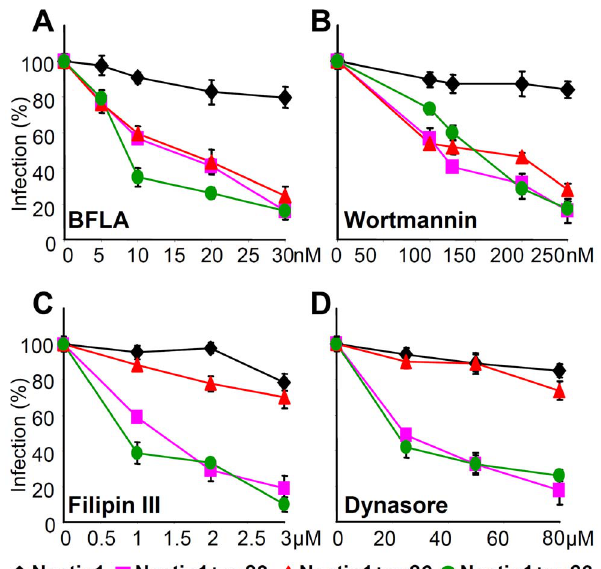
Figure 9. Effect of expression of a v b 6- or a v b 8-integrin on the pathway of HSV entry, defined through sensitivity to specific inhibitors. J cells were transfected with plasmids encoding nectin1 (black diamond), nectin1 plus a v b 3-integrin (pink square), nectin1 plus a v b 6-integrin (red triangle), or nectin1 plus a v b 8-integrin (green circle). 48 h after transfection cells were pretreated with increasing amounts of BFLA (A), wortmannin (B), filipin III (C) or dynasore (D) and infected with R8102 (3 pfu/cell) for 90 min at 37 u C in the same medium. Inoculum was removed and cells were overlaid with Dulbecco’s minimal essential medium (DMEM) for 6–8 h. Specific details were as follows. For filipin III and dynasore, cells were preincubated with the compounds at 37 u C for 30 min or 60 min, respectively, and infected for 30 min (30 pfu/cell) in the same medium. Infected cells were overlaid without inhibitor. BFLA or wortmannin were present also after virus absorption. Infection was quantified as detailed in the legend to Fig. 3, and expressed as percentage of untreated cells. Bars show